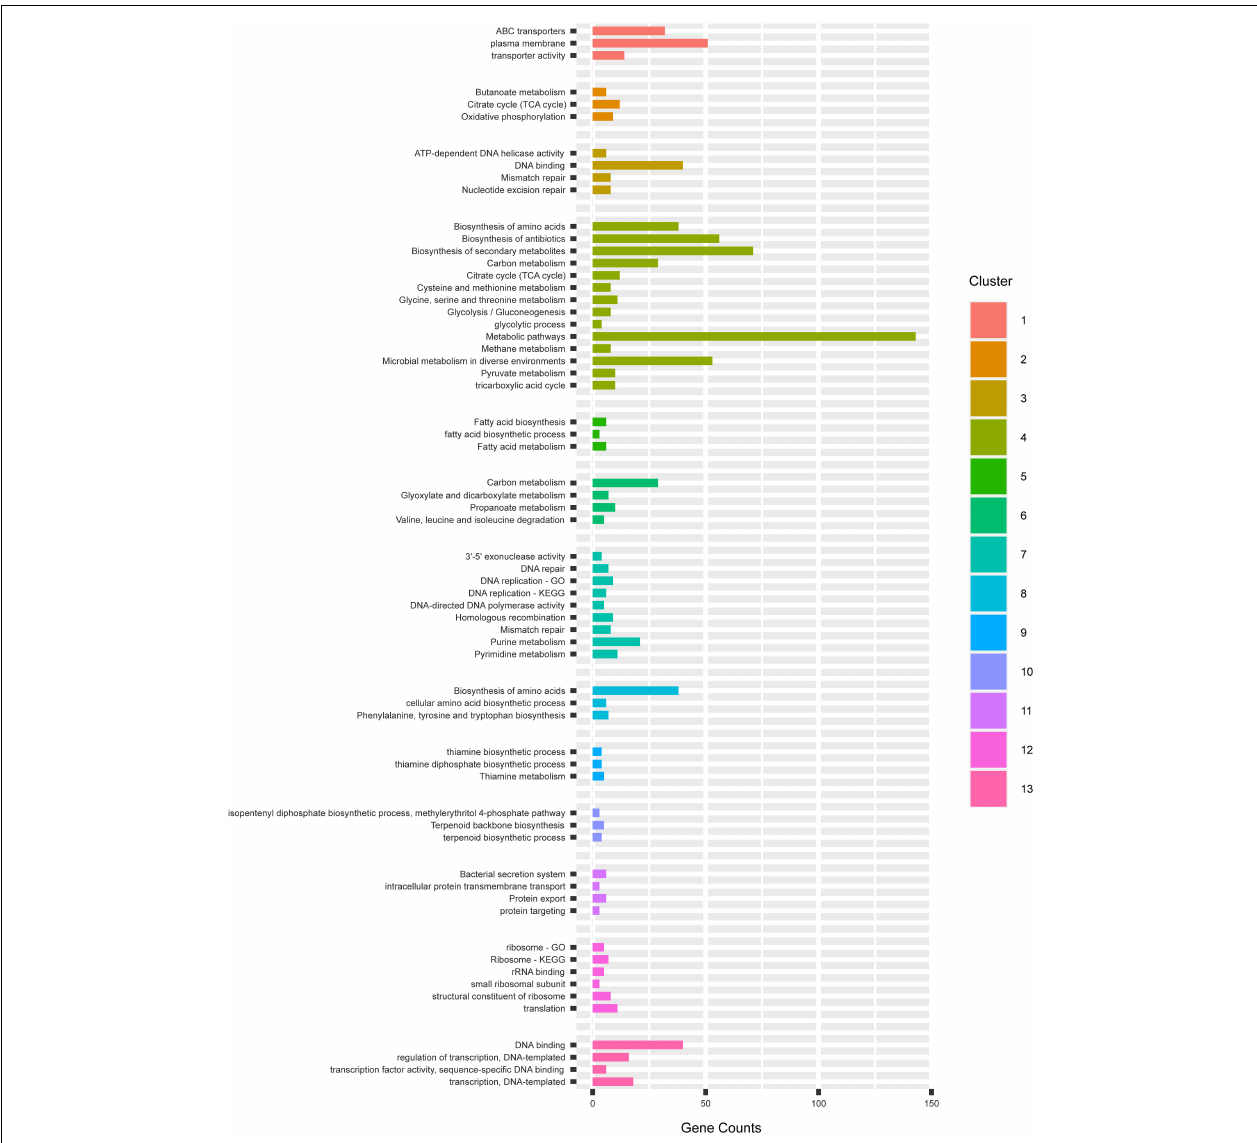
FIGURE 6 | The gene clusters enriching mutations in GO and KEGG categories by DAVID.